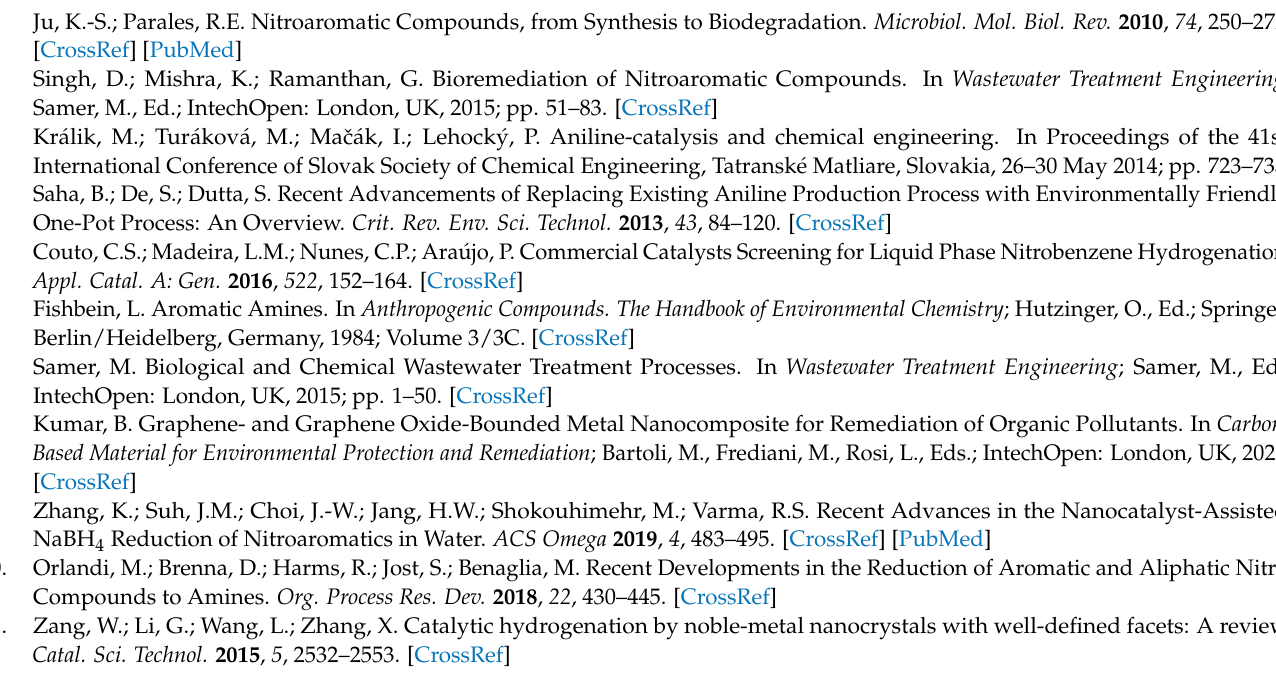
Figure S1: N 2 adsorption-desorption isotherms (a) and pore size distribution (b) for graphite and GO samples; Figure S2: C 1s region high-resolution XPS spectra of the synthesized catalysts and graphene derivatives: GO (a), rGO (b), Ag/GO (c), CeO 2 /GO (d), and Ag-CeO 2 /GO (e); Figure S3: Ag 3d region high-resolution XPS spectra of the Ag/GO (a) and Ag-CeO 2 /GO (c) catalysts and the corresponding Ag MNN Auger region spectra of the Ag/GO (b) and Ag-CeO 2 /GO (d) catalysts; Figure S4: Raman spectra of silver- and/or ceria-containing catalysts and graphene derivatives with an excitation wavelength of 532 nm [51]; Figure S5: 4-NP light absorption peak shift upon NaBH 4 addition (a) and UV–VIS spectra evolution of the working solution during the 4-NP reduction reaction (b) [24]; Figure S6: Kinetic curves (a) and the pseudo-first-order plot of the 4-NP relative concentration logarithm ln( C / C 0 ) versus the reaction time (b) for the Ag-CeO 2 /GO catalyst under various pre- reduction conditions; Table S1: Contribution of carbon chemical states calculated according to the C 1s region high-resolution XPS